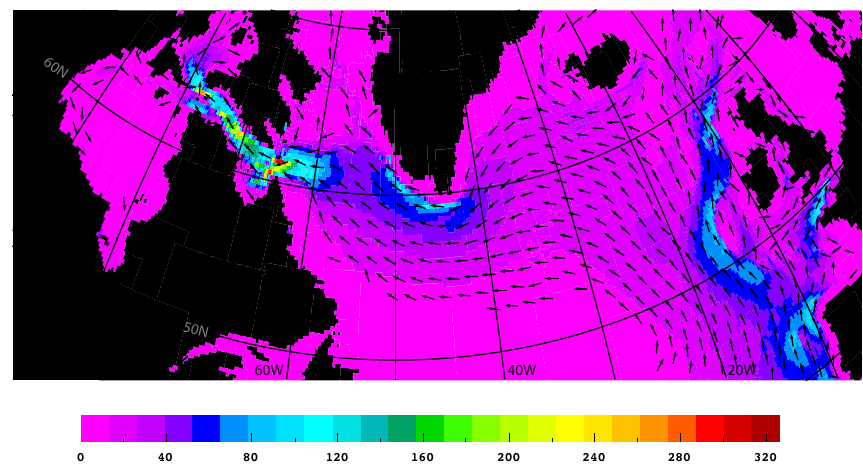
Figure 1. Energy flux vectors for the M2 tide in the north Atlantic, based on from data from OTIS2 (Egbert and Erofeeva, 2002). Energy flux in units of MWm − 1